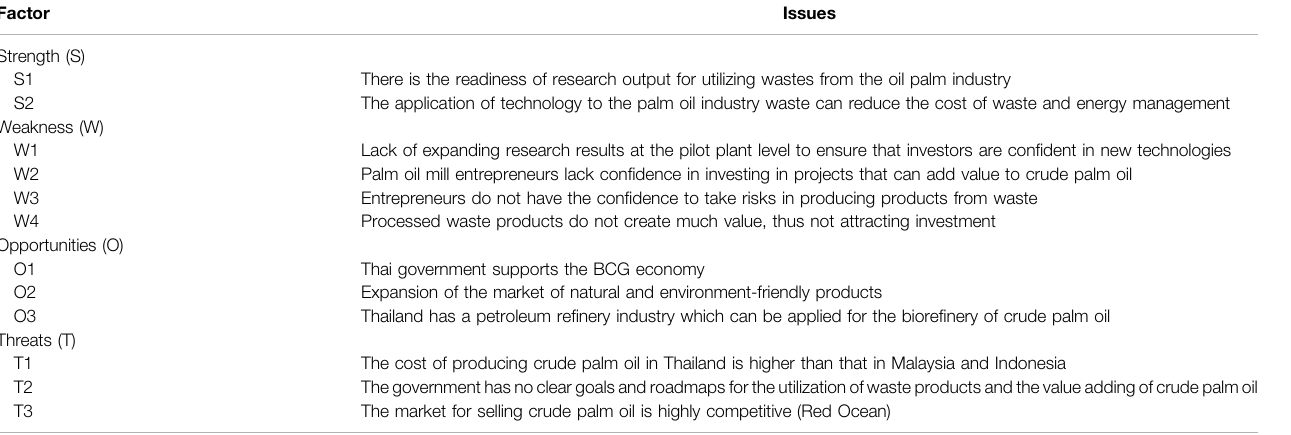
TABLE 5 | SWOT analysis of palm biomass and palm oil value-added technologies.